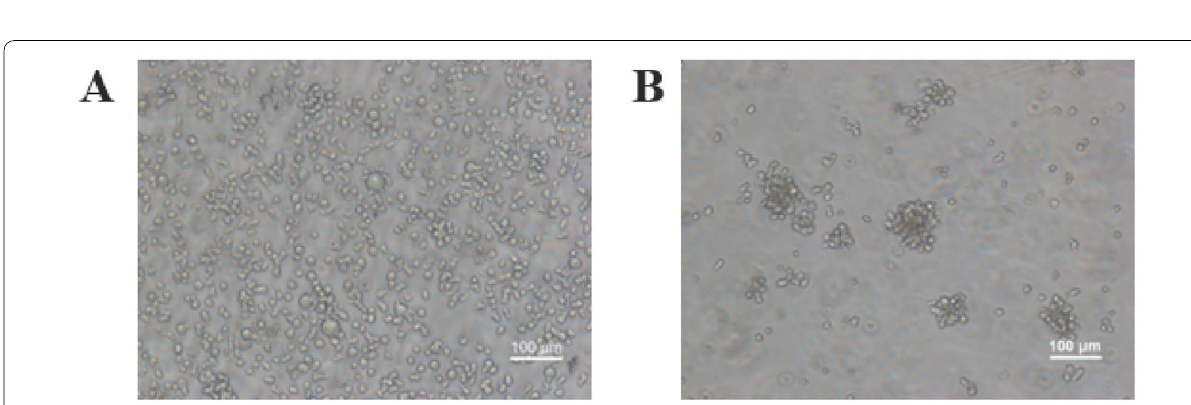
Fig. 6 Morphology of NK‑92 cells after 8 days of culture. A magnetically controlled bioreactor. B culture